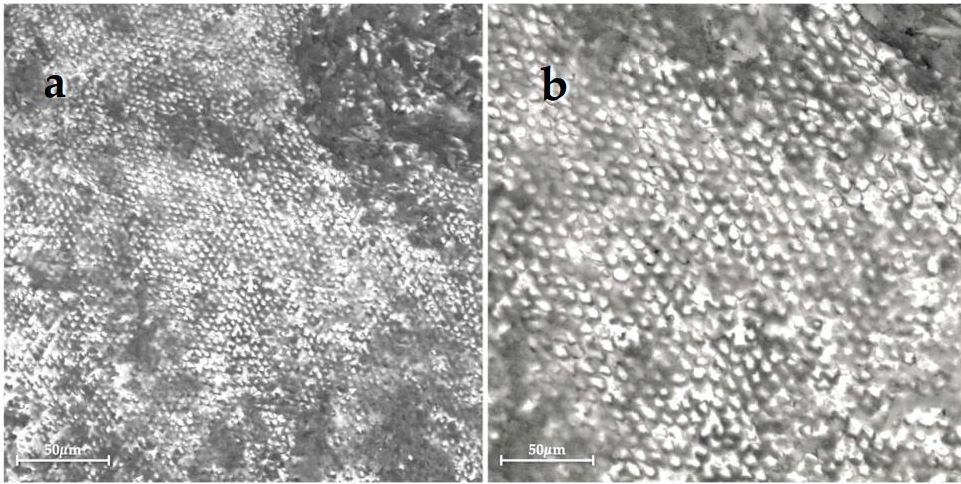
Figure 5. Scanning electron micrographs of Group 5 ( a ) at 500× magnification, showing the presence of a slight irregular enamel surface; and ( b ) at 1000× magnification, showing partial crystal recovery with remineralization within the prismatic structure. Table 1. Descriptive statistic values of the data obtained from EDX measurements of all groups in atomic % expressed as mean ± standard deviation of the Ca, P, and Ca/P ratio: Group 1 (Sound enamel), Group 2 (Demineralized enamel), Group 3 (CPP-ACP); Group 4 (n-HA), Group 5 (NaF), and Group 6 (F-ACP), respectively.